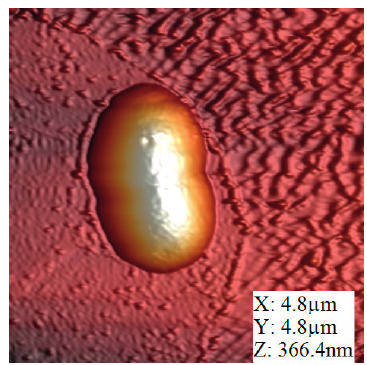
Figure 6. Shear force image of a single E. coli bacterium. Image size is 4.8 μ m × 4.8 μ